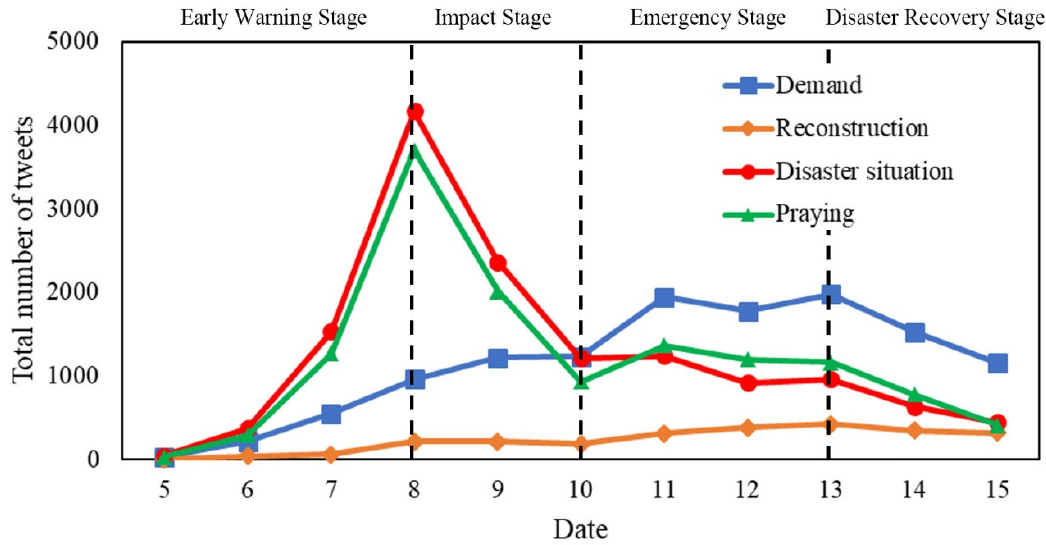
Figure 5. Daily changes in the topic of public discussion from 5 November 2013 to 15 November 2013.